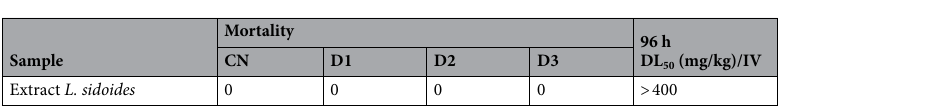
Figure 6. Effect of the aqueous extract of L. sidoides on the locomotor activity of adult zebrafish ( Danio rerio ) in the Open Field Test (0-5 min) ( A ), in the light & dark test ( B ) and on the mechanism of action anisolytic ( C ). DZP—diazepam (10 mg/kg; 20 µL; i.p.). Control—3% DMSO (20 µL; i.p .). Fmz—Flumazenil (4 mg/kg; 20 µL; i.p .). Values represent the mean ± standard error of the mean (S.E.P.M.) for 6 animals/group. ANOVA followed by Tukey (*p < 0.05, **p < 0.01, ****p < 0.0001 vs. vehicle; ### p < 0.001, #### p < 0.0001 vs DZP or L. sidoides ).